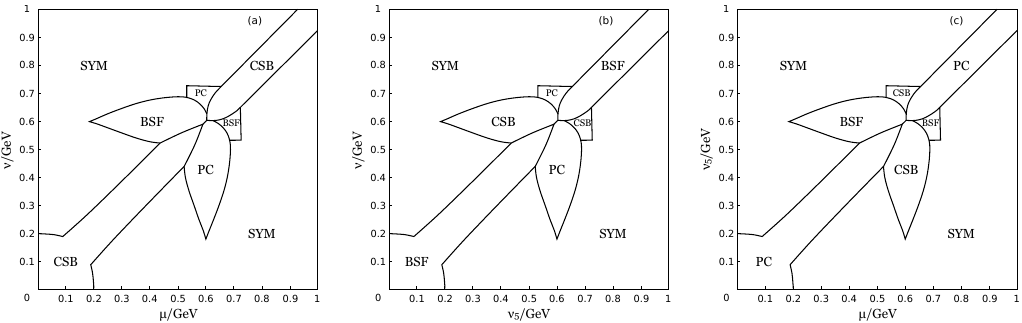
Figure 4 . (a) ( (cid:22); (cid:23) )-phase diagram at (cid:23) 5 = 0 : 6 GeV. (b) ( (cid:23) 5 ; (cid:23) )-phase diagram at (cid:22) = 0 : 6 GeV. (c) ( (cid:22); (cid:23) 5 )-phase diagram at (cid:23) = 0 : 6 GeV. All the notations are the same as in (cid:12)gure 1.